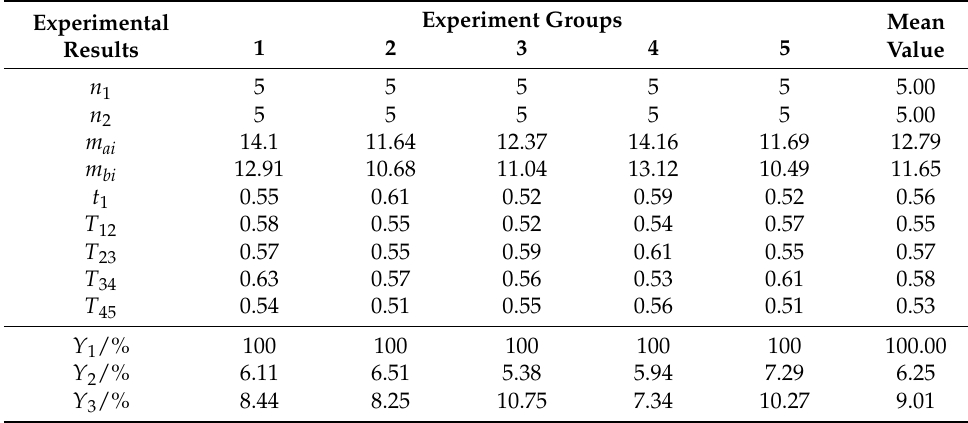
Table 2. Results of group seedling dropping performance